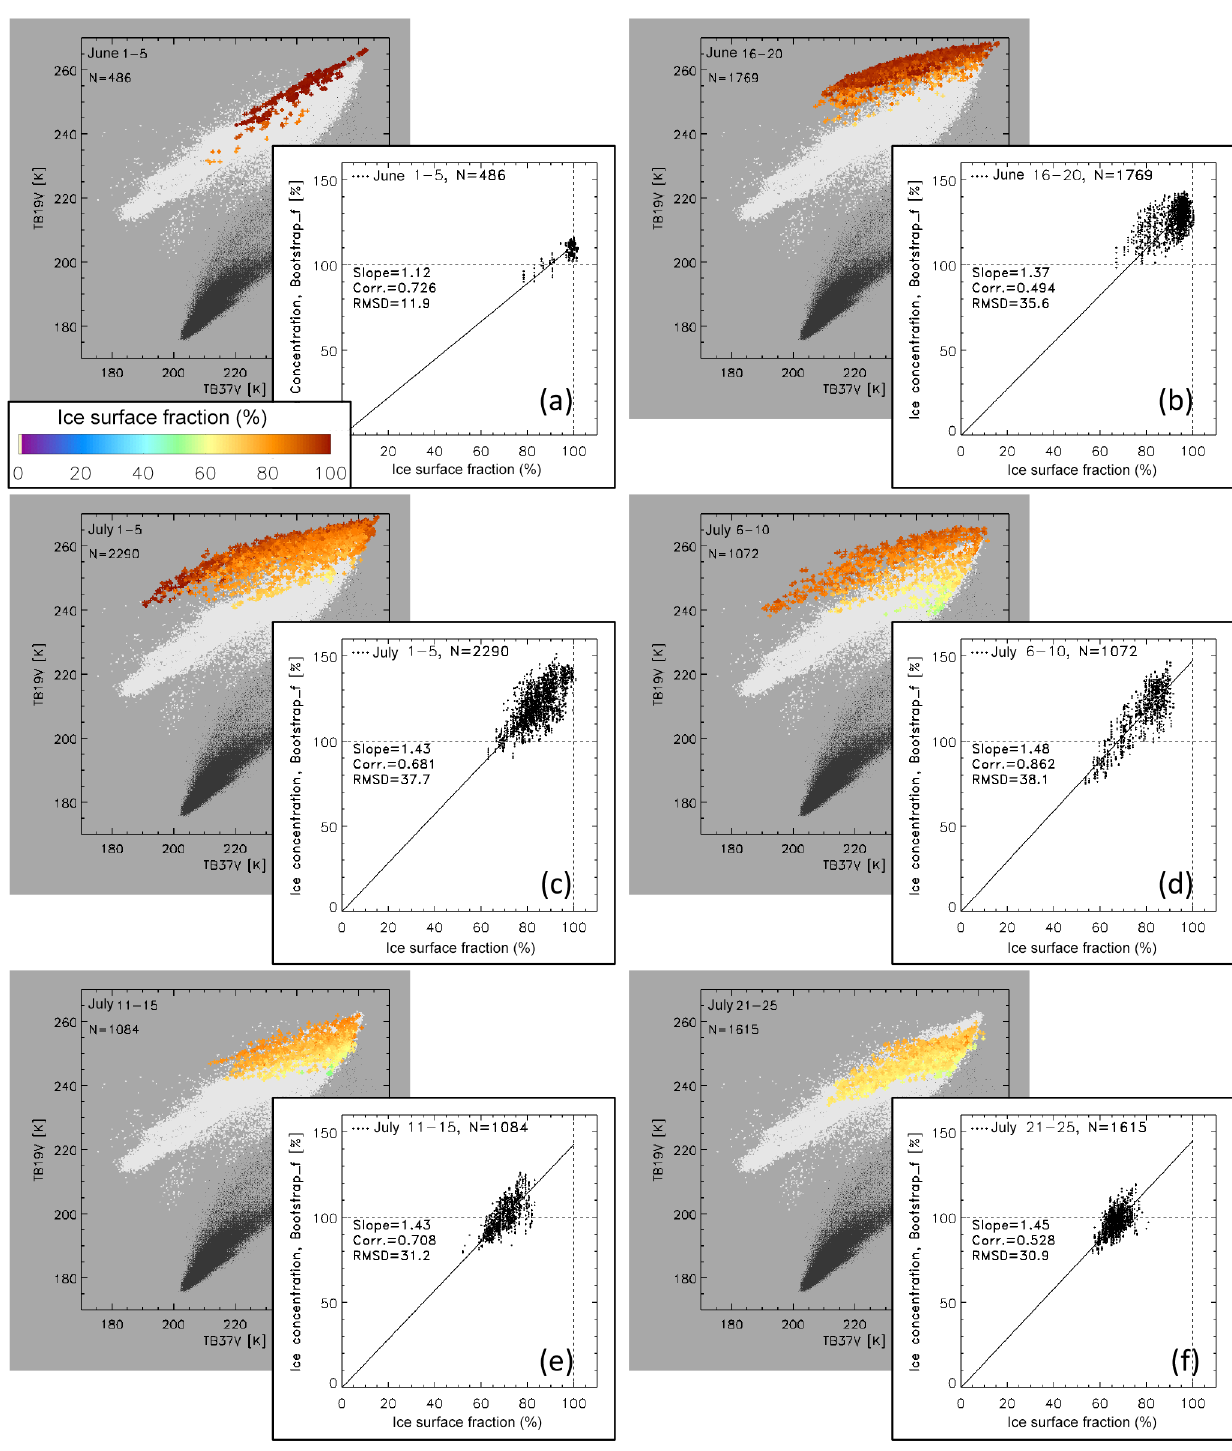
Figure 8. Background: vertically polarized AMSR-E brightness temperature at 19GHz vs. at 37GHz, color-coded with the co-located MODIS ice-surface fraction for the same six selected pentads as in Fig. 7 denoted in the upper left corner of each image, together with the number N of data pairs. For white and black dots, see Fig. 6. Foreground: same as in Fig. 7 but for the Bootstrap_f algorithm.